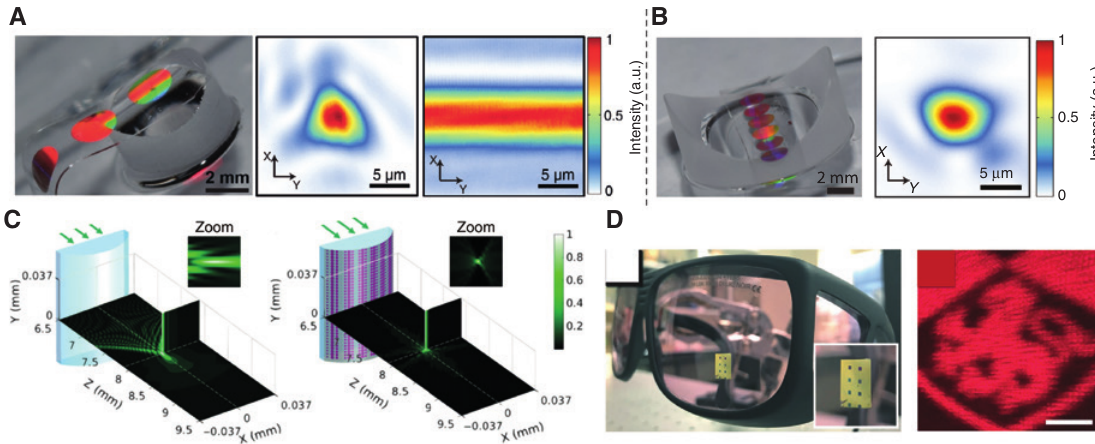
Figure 8: Conformal